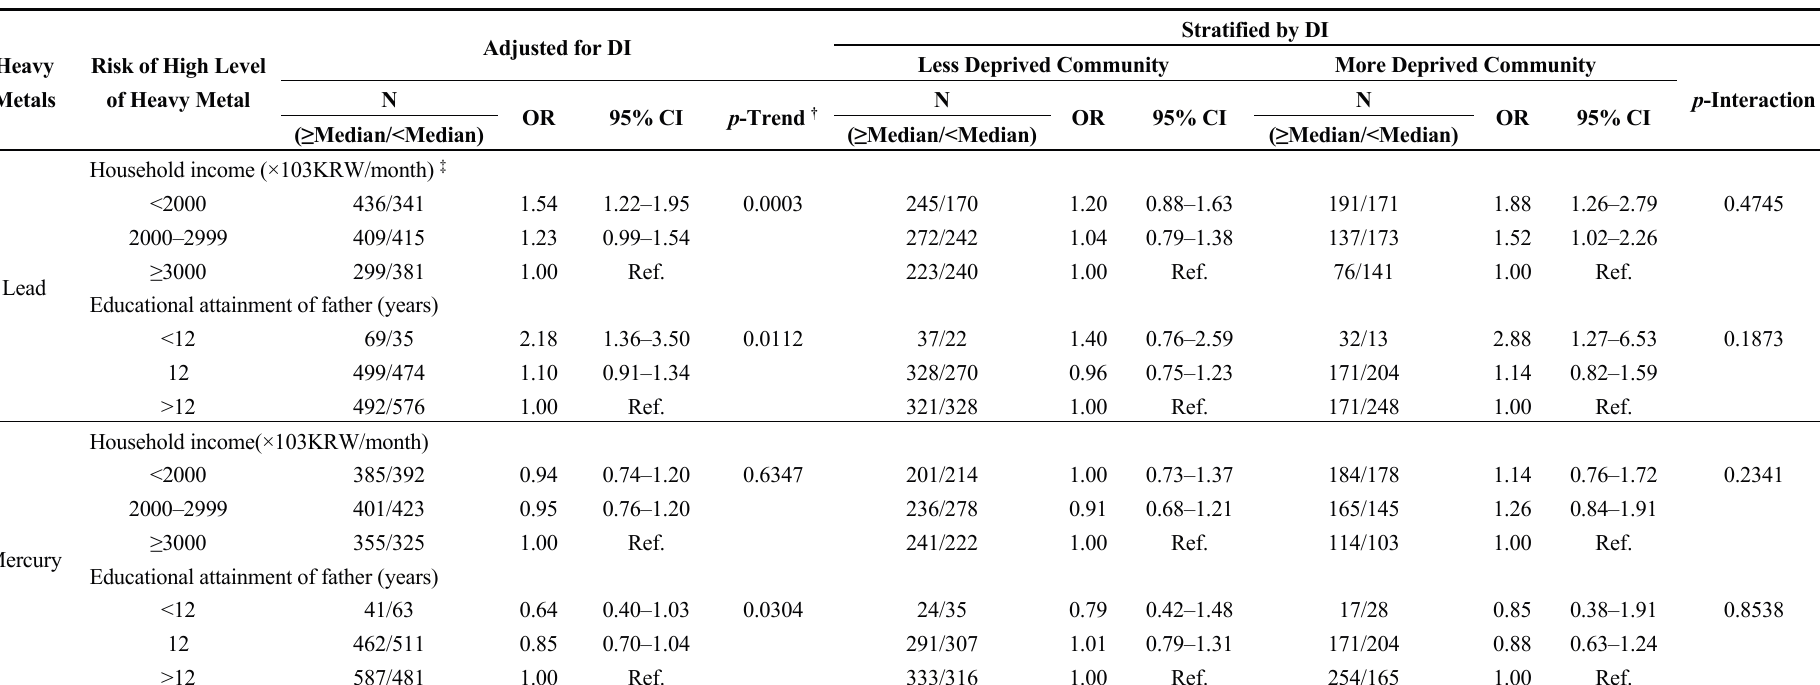
Table 3. Association between high levels of blood lead or mercury and the individual socioeconomic position adjusted for or stratified by the deprivation index of the community in 2281 children at enrollment, CHEER, 2005–2006,